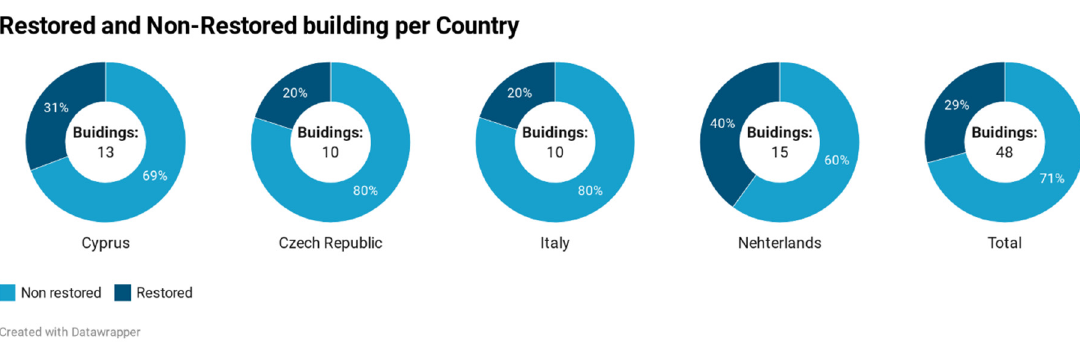
Figure 8. Age (X axis) and Level of damage (Y axis) of the non-restored buildings in each country.